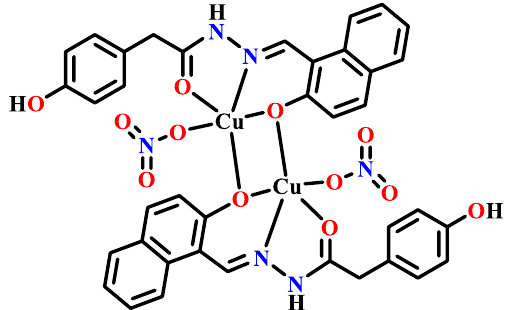
Figure 58. A symmetric binuclear copper(II) complex of 2-hydroxynaphthylhydrazone with p -hydroxyphenylacetamide as a side chain.